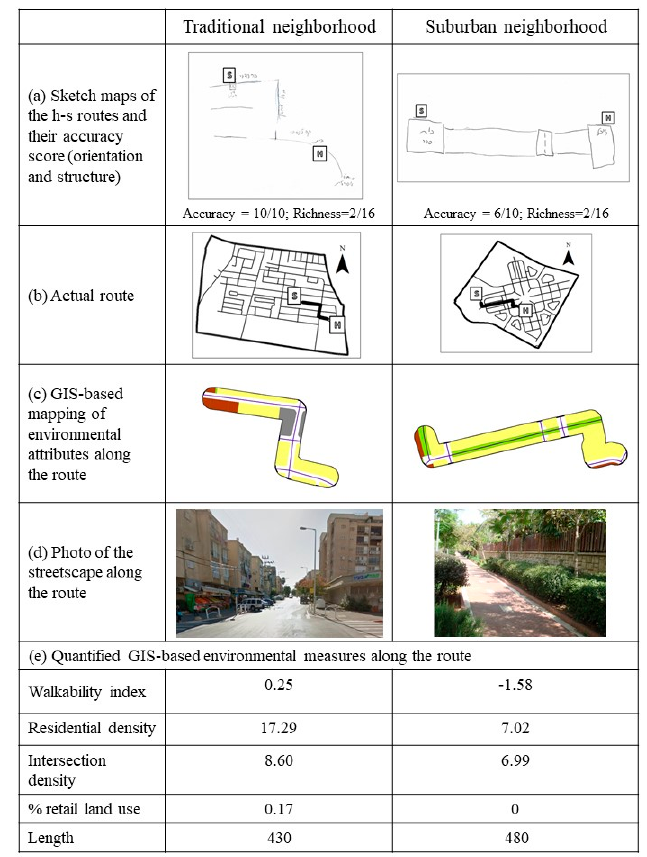
Figure 3. ( a ) Sketch maps of home-school routes and their accuracy score (orientation and structure), ( b ) Maps of the actural routes, ( c ) GiS based mapping of streets and land uses along the routes, ( d ) Street view photos of the routes, ( e ) Quantified GIS-based environmental measures along the route.